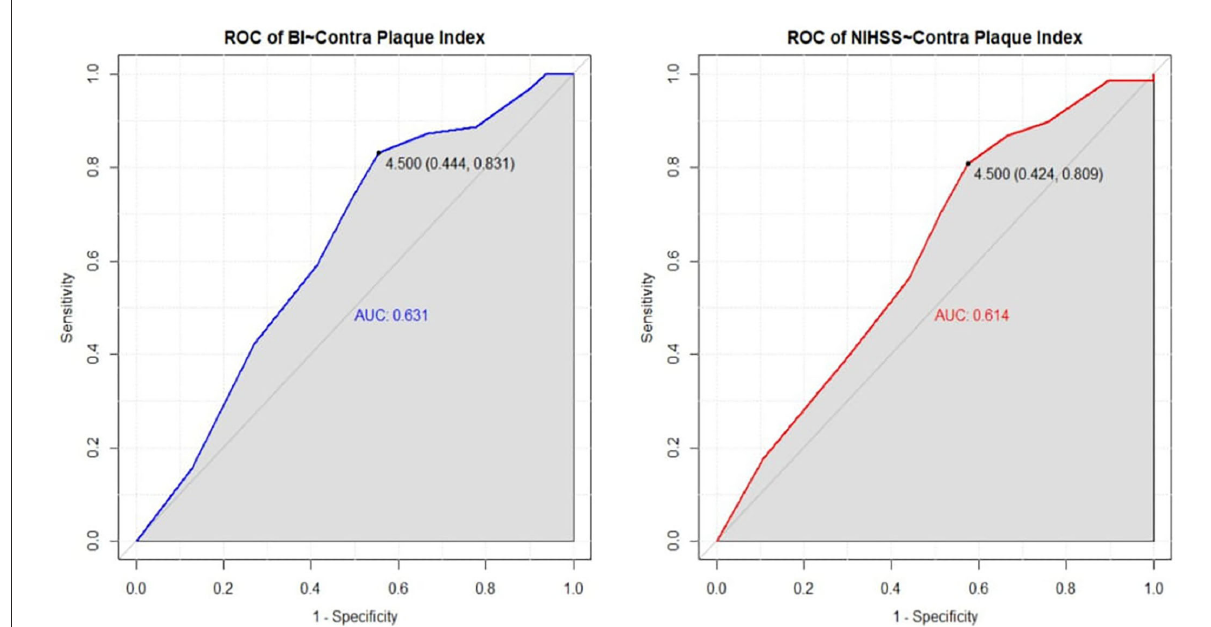
FIGURE3 ROC curve of Contralateral Plaque Index from Barthel Index and NIHSS assessment. It demonstrated the result of the ROC curve of significant variable contralateral plaque index. In Barthel Index, the ROC curve finds the cut-off point of contralateral plaque index which is 4.5 with Youden’s index (0.444, 0.831), and the area under the curve (AUC) indicating the overall accuracy of the degree of disability and the variables is 0.631. In NIHSS, the ROC curve finds the cut-off point of the contralateral plaque index which is 4.5 with Youden’s index (0.424, 0.809), and the area under the curve (AUC) is 0.614. It reveals that the patient will not improve when the contralateral plaque index is over 4.5 in assessment outcomes, both Barthel Index and